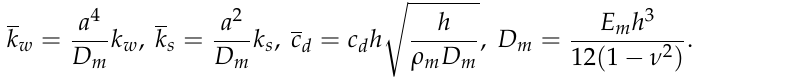
(cid:112) ρ h / D 0 for isotropic square plates resting